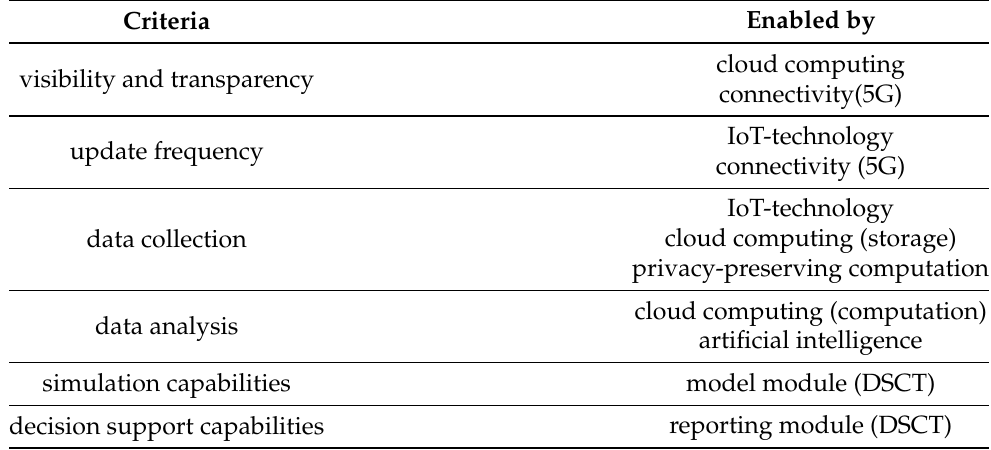
Table 2. Validation of